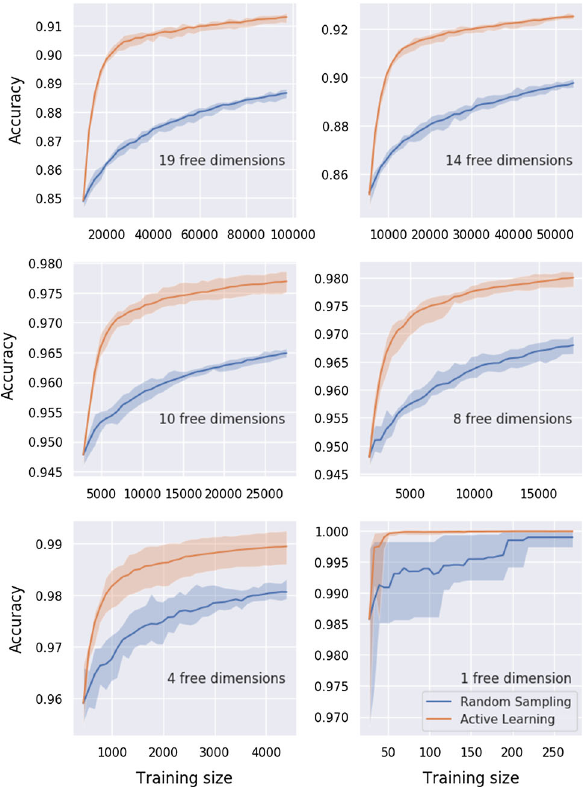
Fig. 6 Accuracy development on model exclusion in the simplified versions of the 19-dimensional model for new physics (pMSSM) for randomsamplingandactivelearningusingarandomforestasalgorithm and an infinite pool. True labeling was provided by a machine learning algorithm trained on model points and labels provided by ATLAS [1]. Thebandsshowtherangeinwhichallcurvesofthatcolourlaywhenthe experiment was repeated 7 times. The subsplots show the development for different dimensionalities for the simplified models. The relative gain of active learning over random sampling is approximately equal for all six of these plots, showing that active learning has added benefit even for smaller parameter